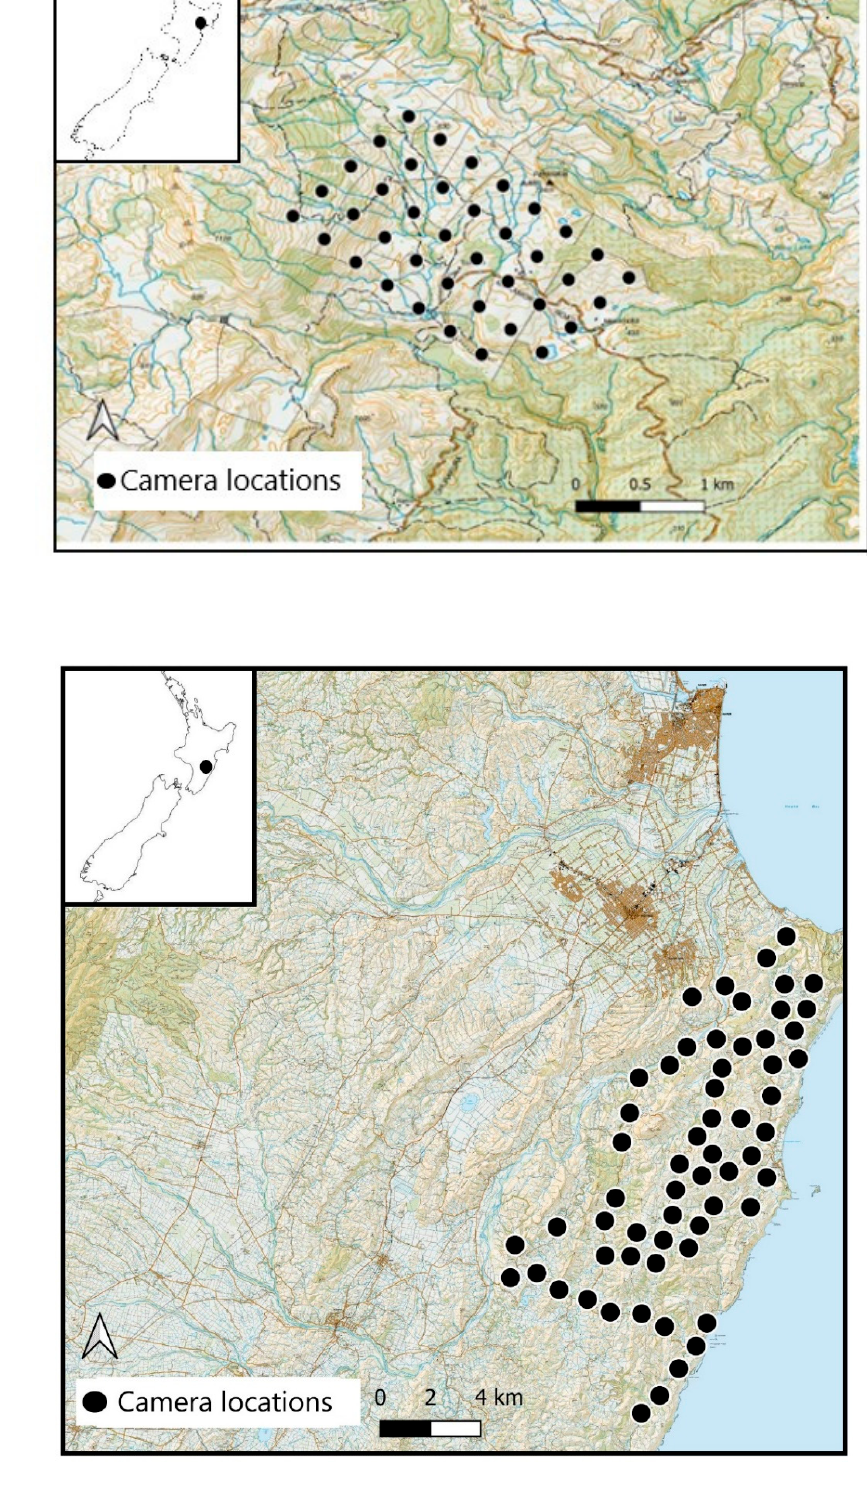
Figure 1. Camera locations at Site 1 ( a ) and Site 2 ( b ), Hawkes bay, North Island, New Zealand. 170